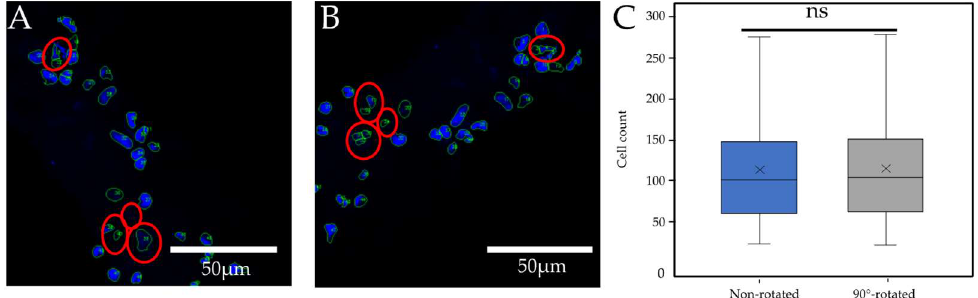
Figure 10. Comparison of the segmentation of a non-rotated in a 2-z-substack. ( A ) and a 90° rotated image ( B ). Differing segmentation is marked with red circles. There was no difference in the distribution of the two groups ( C ). Middle line = median; X = mean; box = interquartile range (IQR); upper/lower whisker (UW/LW) ≈1.5xIQR. The result of the Mann-Whitney-U test is shown using the